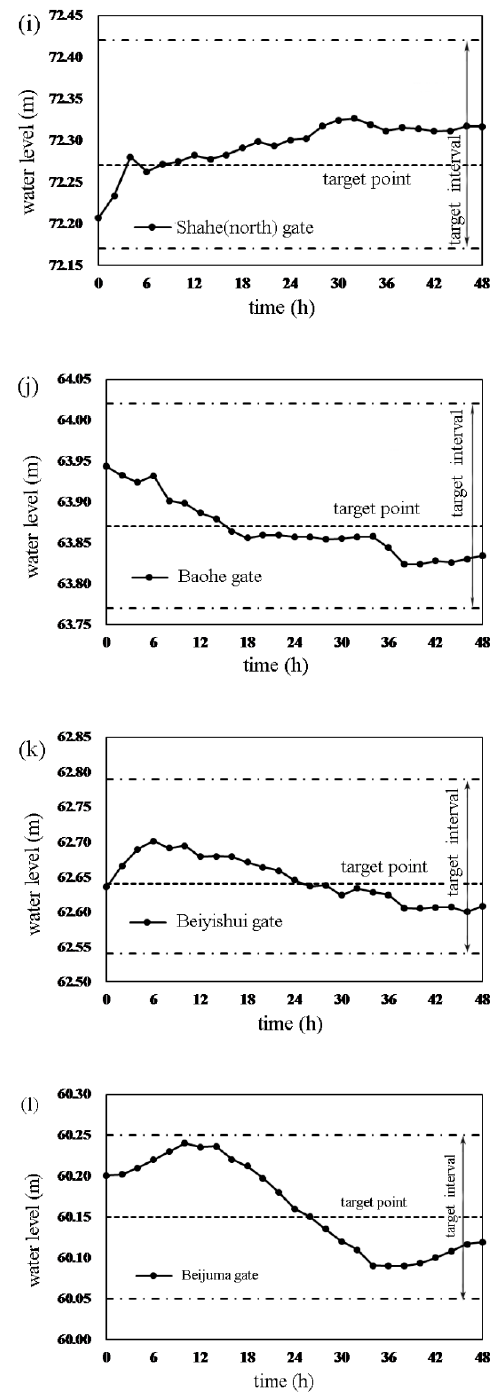
Figure 7. Variations of water level upstream of the check gates (partially listed due to space limitation). ( a ) Diaohe gate; ( b ) Shahe gate; ( c ) Zhanghe-crossing gate; ( d ) Mangniuhe gate; ( e ) Xiaohe gate; ( f ) Guyunhe gate; ( g ) Hutuohe gate; ( h ) Cihe gate; ( i ) Shahe(north) gate; ( j ) Baohe gate; ( k ) Beiyishui gate; ( l ) Beijuma gate.